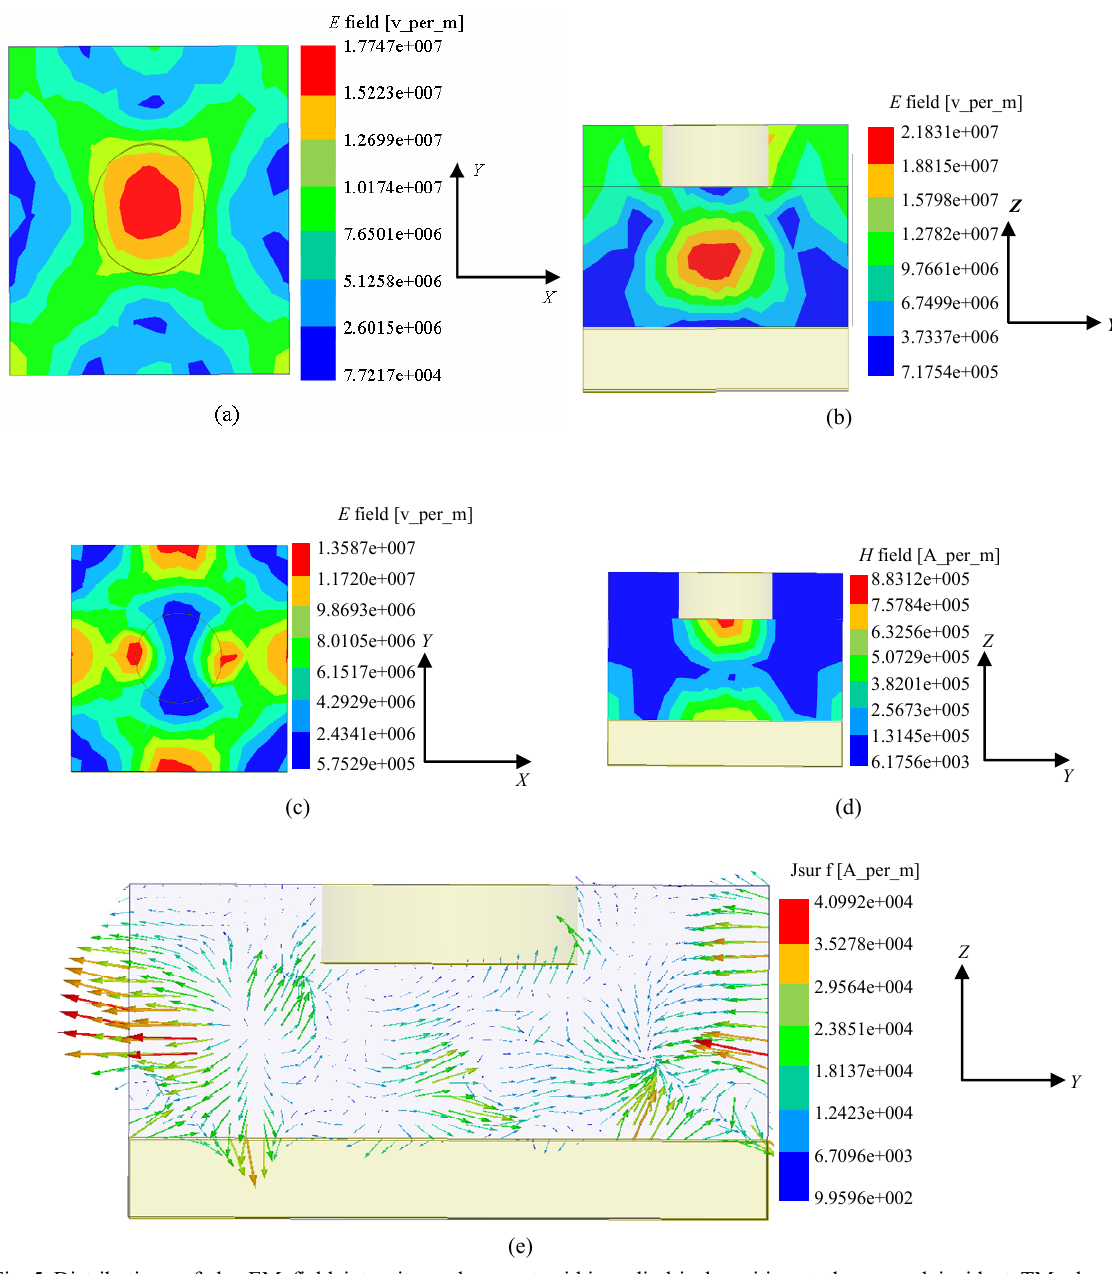
Fig. 5 Distributions of the EM field intensity and current within cylindrical cavities at the normal incident TM plane wave: (a) amplitude of the electric field in the middle of the dielectric layer in the X - Y plane at f = 53.7 THz, (b) amplitude of the electric field in the middle of the dielectric layer in the Y - Z plane at f =53.7 THz, (c) amplitude of the electric field on the top surface of the dielectric layer at f = 53.7 THz, (d) amplitude of magnetic field in the middle of the dielectric layer in the Y - Z plane at f = 53.7 THz, and (e) distribution of the current in the middle of the dielectric layer in the Y - Z plane at f = 53.7